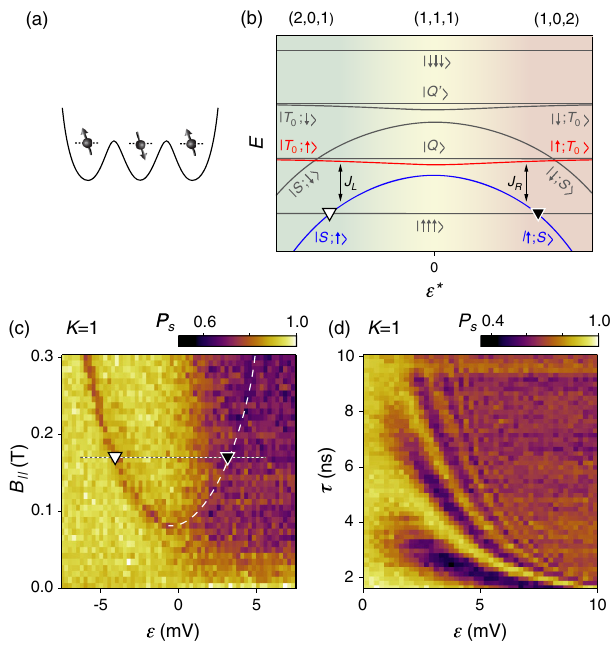
FIG. 5. (a) Schematic of the three-electron triple dot, which serves as a reference for discussing the odd-occupied multi- electron dot tunnel coupled to the double dot. (b) Energy diagram of the three-electron triple-dot spin states for a finite external magnetic field. (c) Measured leakage spectrum for the three- electron triple dot. Markers indicate leakage features attributed to the level crossings marked in (b). (d) Measured exchange oscillations reveal a monotonically increasing frequency, corre- ð ε Þ in sponding to monotonically increasing J R